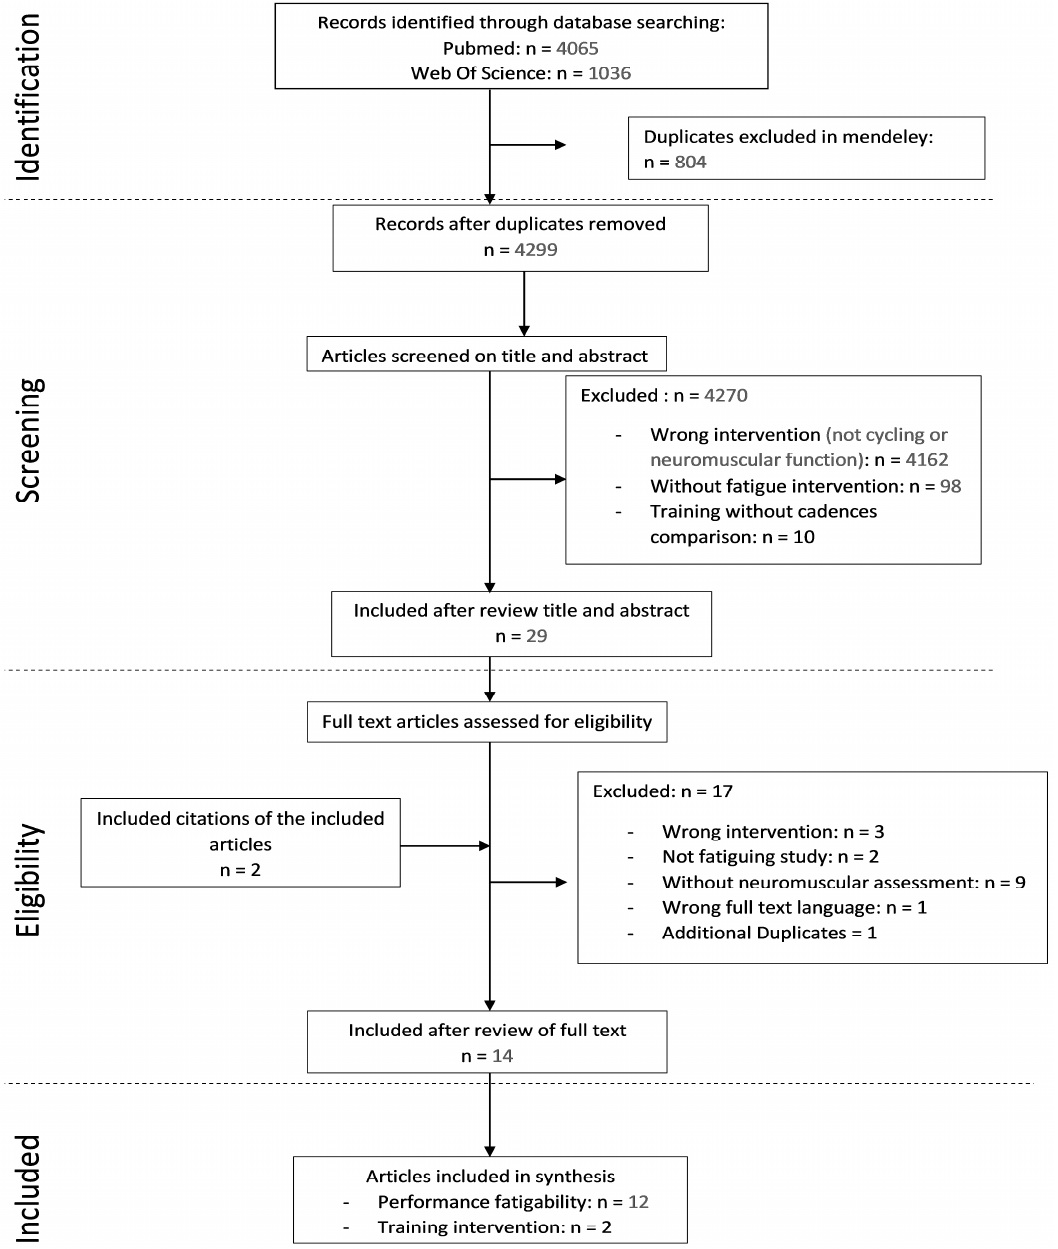
Figure 1. Flow diagram of the reviewing methods based on PRSIMA guidelines .